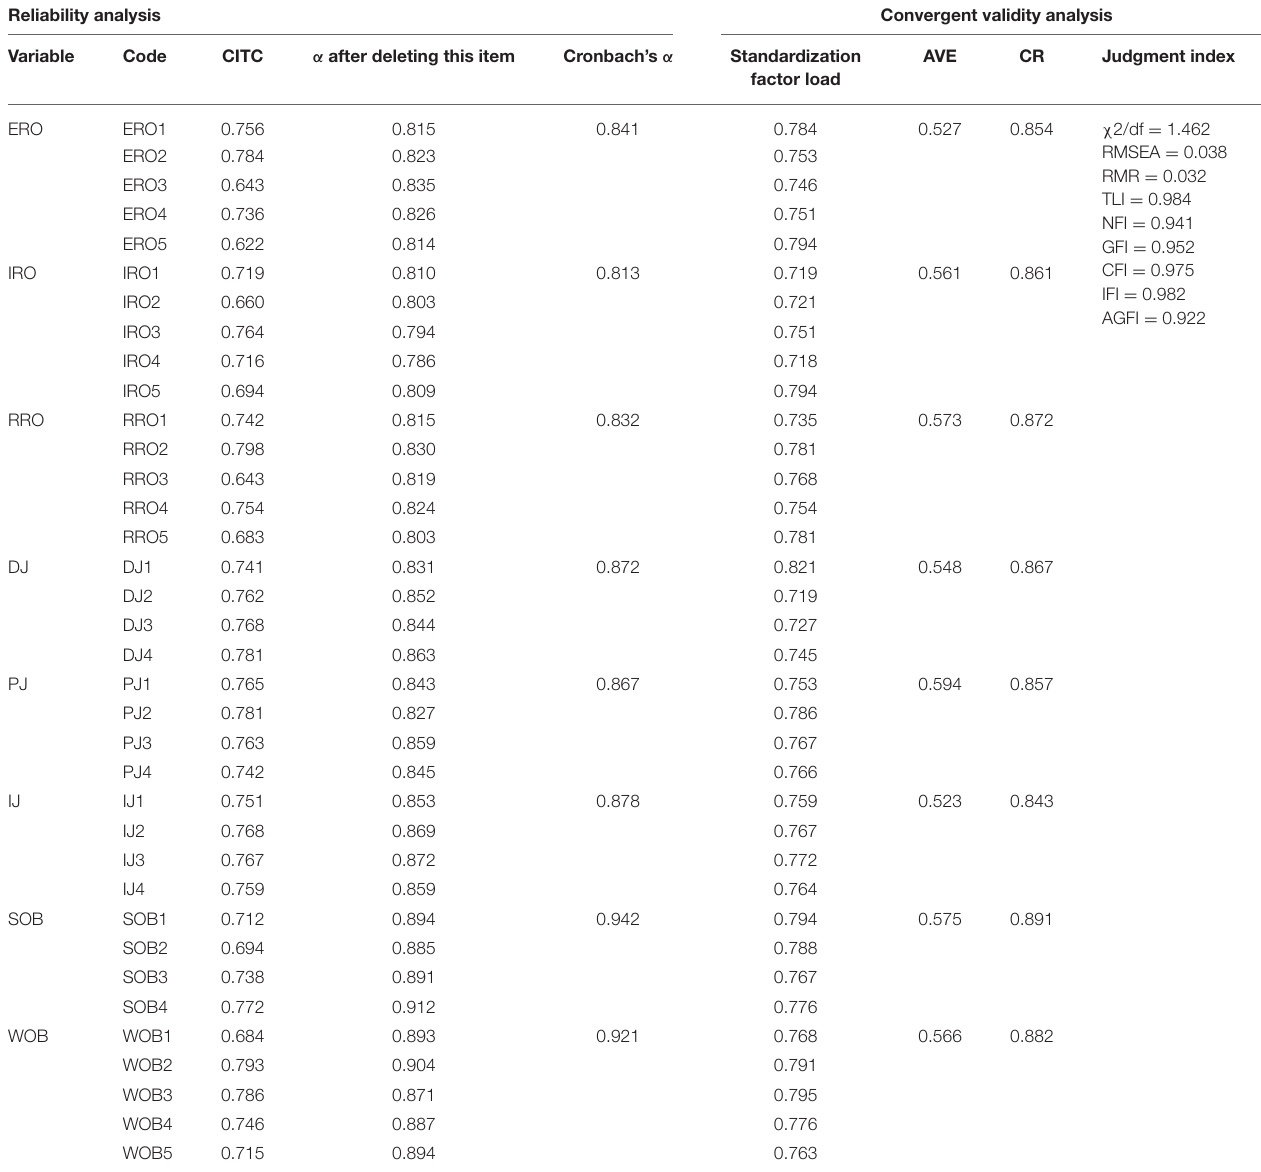
TABLE 3 | Reliability and convergent validity analysis